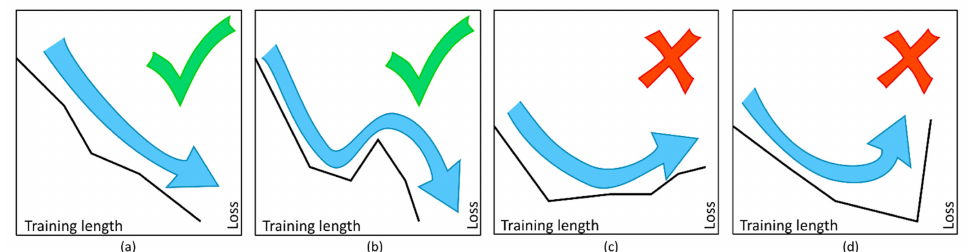
Figure 22. Comparison of the different criteria adopted for the ANN training. ( a ) “Greedy” learning; ( b ) “jumping” out of a local tiny minimum; ( c ) halt at large minima; ( d ) halt at sharp growths in loss. Figure reprinted from Ref. [119] under the terms of the CC-BY